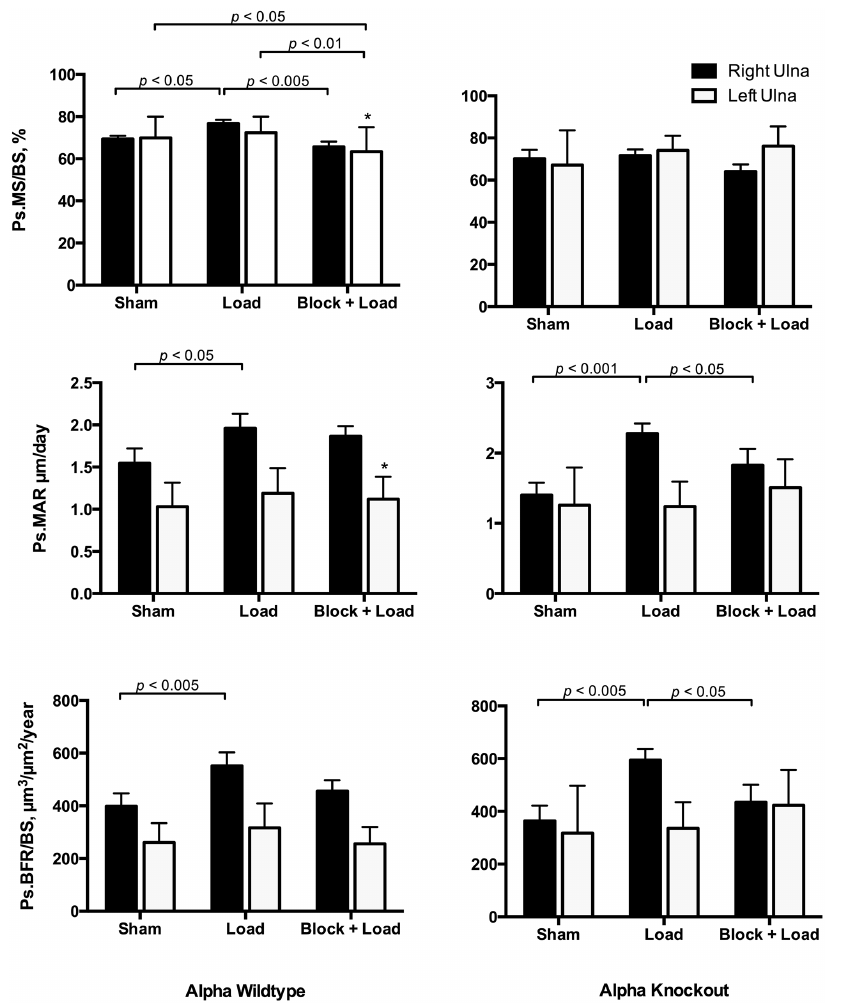
Fig. 2. Load-induced periosteal bone formation responses are different in CGRP a wildtype and knockout mice. Cyclic loading of the right ulna in wildtype mice induced adaptive responses in periosteal mineralizing surface (Ps.MS/BS), periosteal mineral apposition rate (Ps.MAR), and periosteal bone formation rate (Ps.BFR/BS). When brachial plexus anesthesia (BPA) was performed before loading, the Ps.MS/BS response to loading was significantly blocked ( p , 0.005). In CGRP a knockout mice, Ps.MS/BS response to loading was lost, but Ps.MAR and Ps.BFR/BS response to loading was preserved. Blocking of Ps.MAR and Ps.BFR/BS responses in the right ulna after right ulna loading was enhanced in CGRP a knockout mice, compared with wild-type mice. * p , 0.05 versus left ulna in Block + Load CGRP a knockout mice. Sham – sham loaded group, Load – loaded group, Block + Load – BPA treatment before loading. n 5 11–14